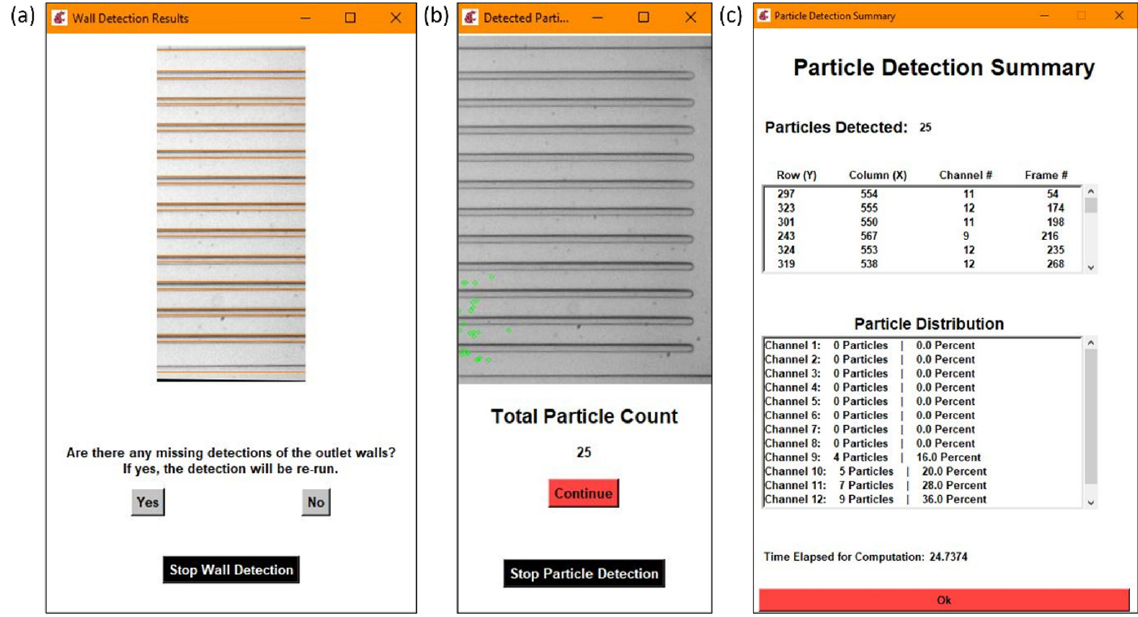
Figure 4. Each section is an example of the following: ( a ) wall detection results, ( b ) particle detection results, ( c ) a detailed summary of the particle detection results with the particle distribution calculation.